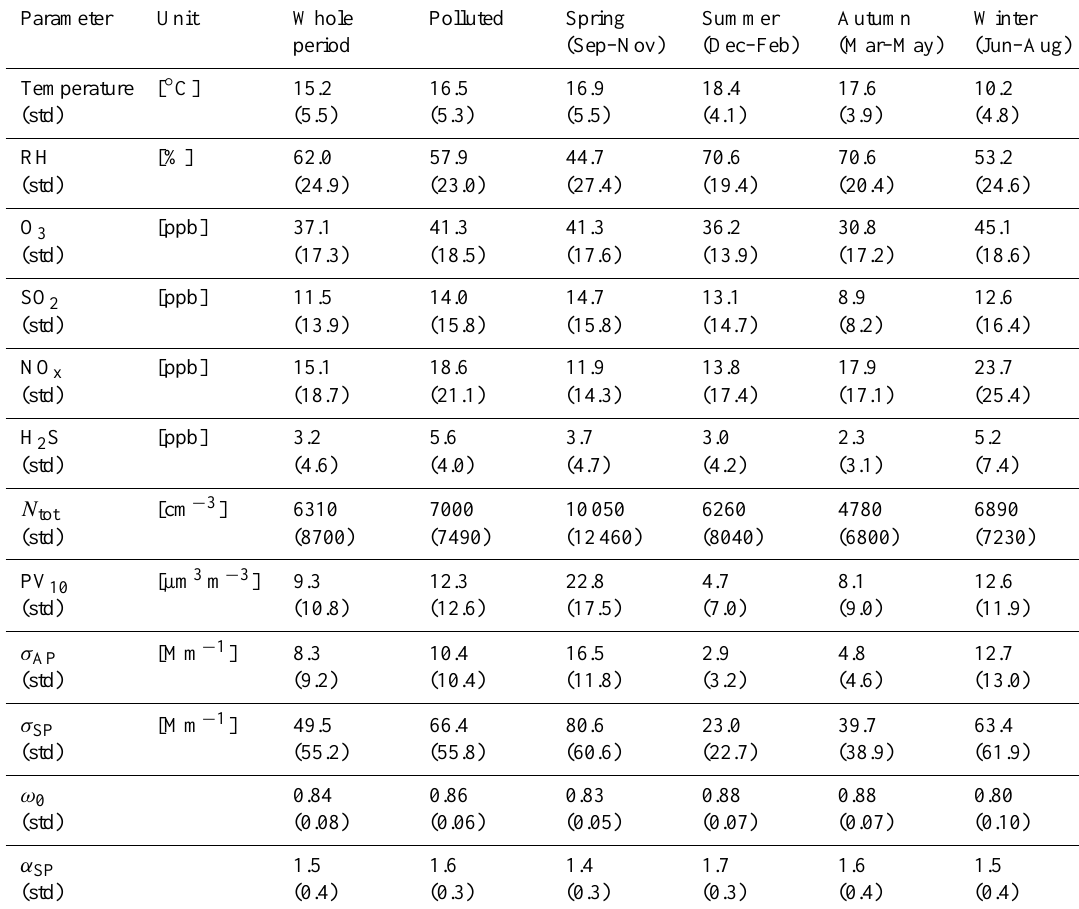
Table 2. Statistical summary of 15-min averaged data during the whole period, periods when trajectories crosses over multiple emission